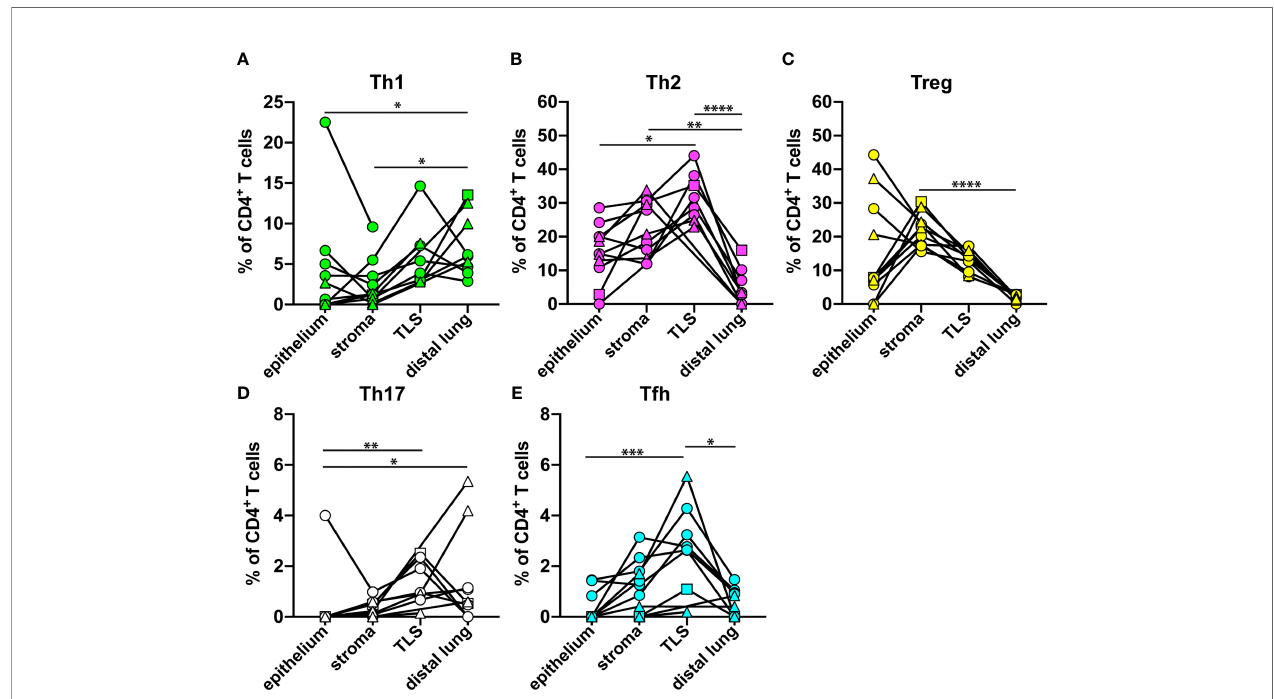
FIGURE 6 | Relative frequency of each Th cell subset in different microanatomical regions. The data from Figures 3 – 5 were used to compare the percentage of each Th subset (of all CD3 + CD8 - Th cells) in tumor epithelium (n=11), tumor stroma (n=11), tertiary lymphoid structure (TLS, n=8), and distal lung (n=9) of NSCLC patients. (A) Th1 cells (T-bet + CD3 + CD8 - ). (B) Th2 cells (GATA3 + CD3 + CD8 - ) detected by mAb clone L50-816. (C) Treg cells (FOXP3 + CD3 + CD8 - ). (D) Th17 cells (ROR- g t + CD3 + CD8 - ). (E) Tfh cells (BCL6 + CD3 + CD8 - ). Each symbol in the graphs represents one patient. Squamous cell carcinoma patients are indicated by triangles, and adenocarcinoma patients by circles. The square symbol indicates the adenosquamous carcinoma patient. Statistical calculations were performed with non-parametric Kruskal-Wallis analysis and Dunn´s post-hoc test. *p<0.05, **p<0.01, ***p<0.001,